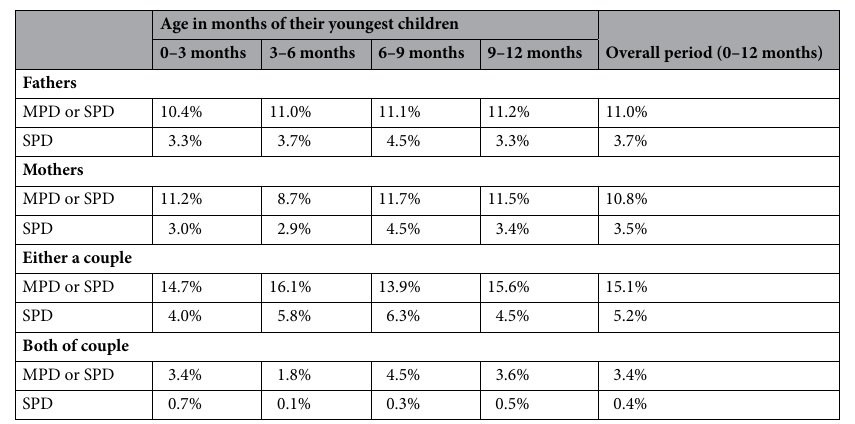
Table 2. Prevalence of moderate and severe psychological distress among parents by age in months in the first year after birth (n = 3,514). MPD (moderate psychological distress): the prevalence of the K6 score between 9 and 12 points. SPD (severe psychological distress): the prevalence of the K6 score ≥ 13 points. MPD or SPD: the prevalence of the K6 score ≥ 9